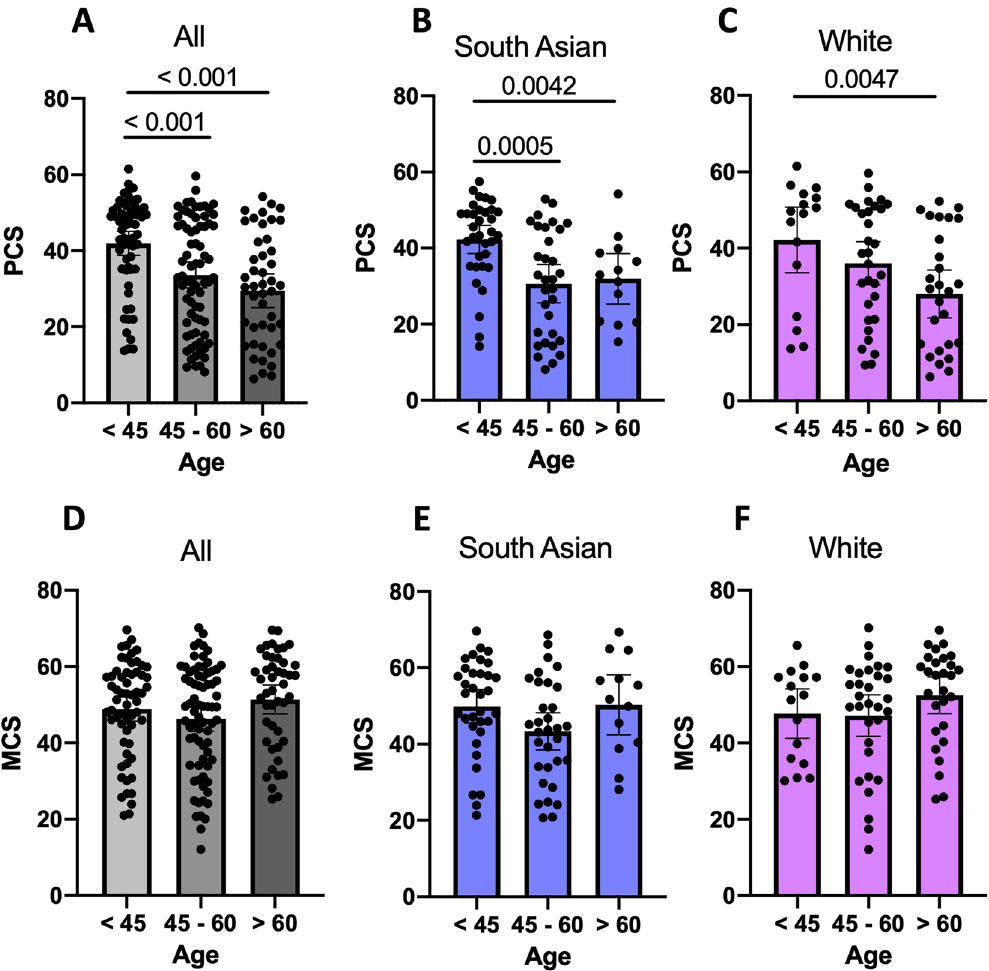
Figure 1. Physical and Mental Component Scores stratified by age. PCS physical component summary, MCS mental component summary. ( A ) All NAFLD PCS stratified by age; ( B ) South Asian PCS stratified by age; ( C ) White PCS stratified by age; ( D ) All NAFLD MCS stratified by age; ( E ) South Asian MCS stratified by age; ( F ) White MCS stratified by